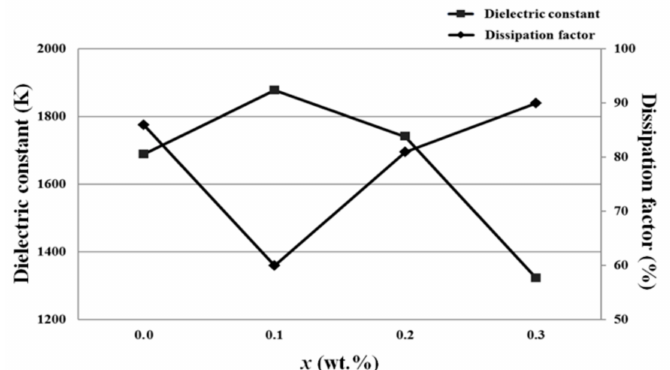
Figure 2. Dielectric constant and dissipation factor (tan δ ) of the 0.98BaTiO 3 -0.02(Ba 0.5 Ca 0.5 )SiO 3 ceramics doped with x wt.% of Dy 2 O 3 (0.0 ≤ x ≤ 0.3) without binder solution and sintered at 1320 ◦ C for 1 h.